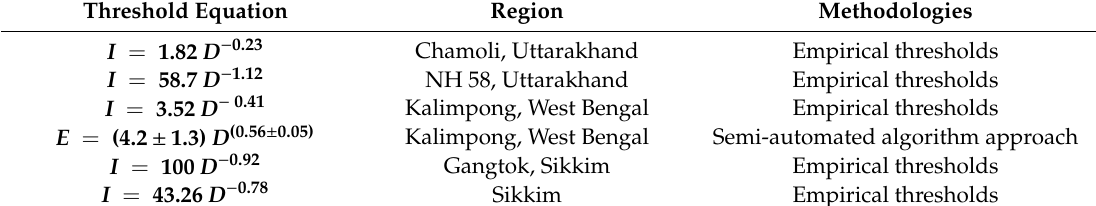
Table 1. Threshold equations generated for various Himalayan regions using several methods (I is Rainfall Intensity (mm/h), while D is Duration (h)).